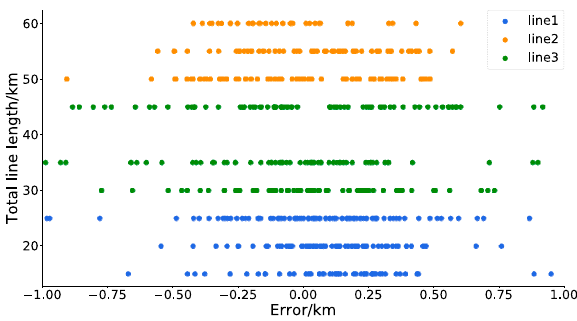
Figure 9. Error of test data set.